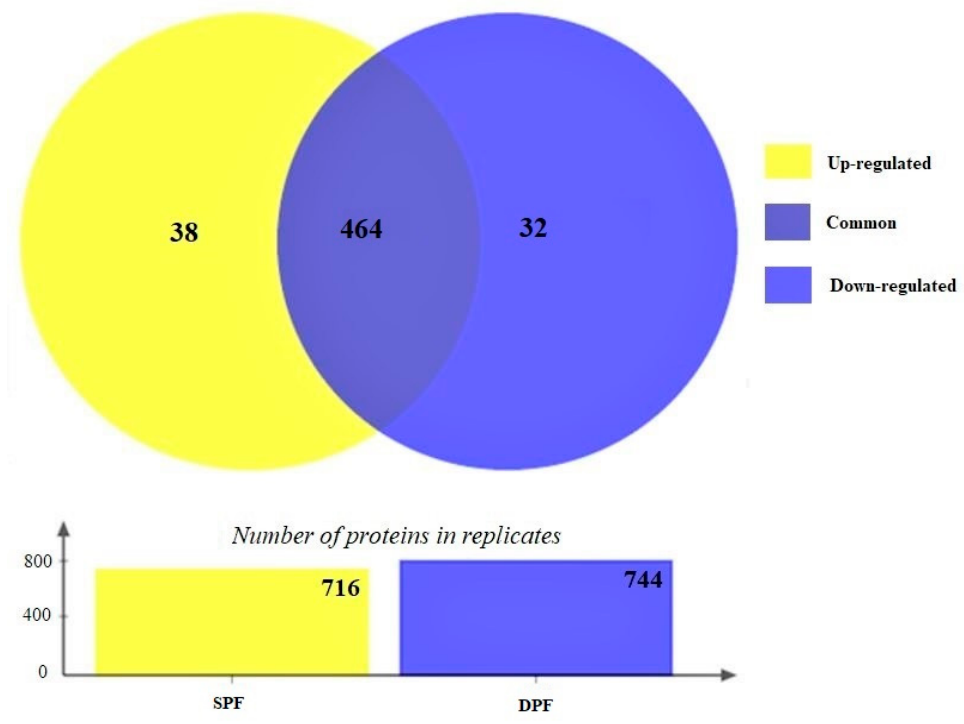
Figure 3. The Venn diagram illustrates a total of 464 common proteins in both experimental groups. The differentially expressed proteins were calculated based on p -value and fold change ( p < 0.05 and FC ± 1.2). Based on the criteria 38 proteins were upregulated, and 32 proteins are down- regulated.